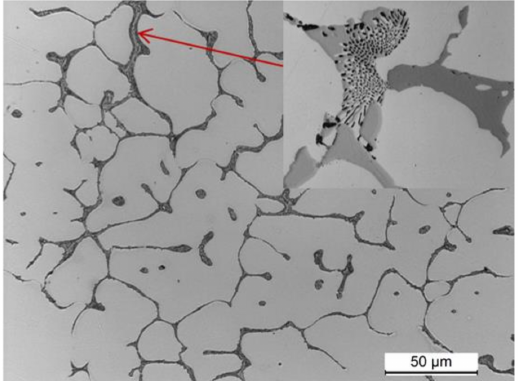
Figure 6. LM microstructure of the 2017A alloy obtained from recycling after